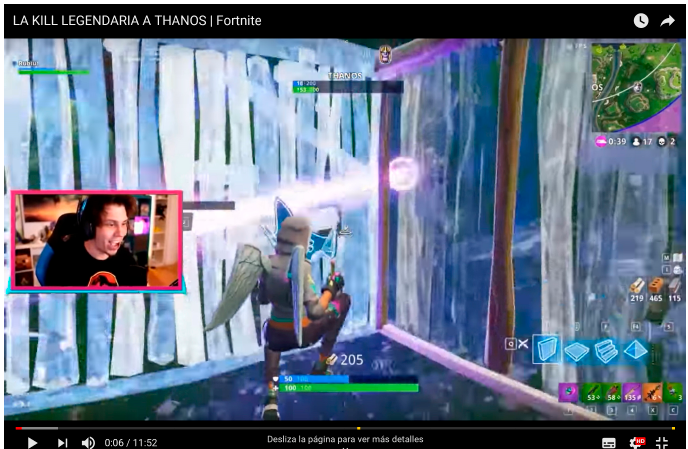
Figure 13. La kill legendaria a Thanos/The Legendary Thanos Killing | Fornite . © elrubiusOMG.